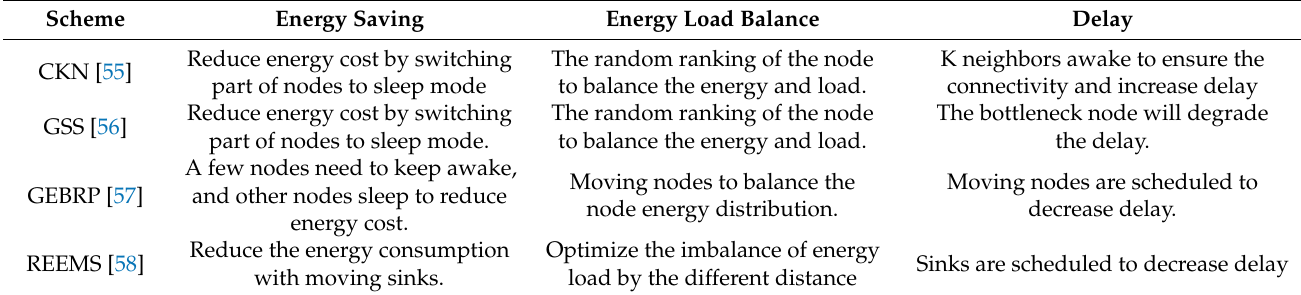
Table 2. The comparisons of different energy-efficient scheduling-based routing